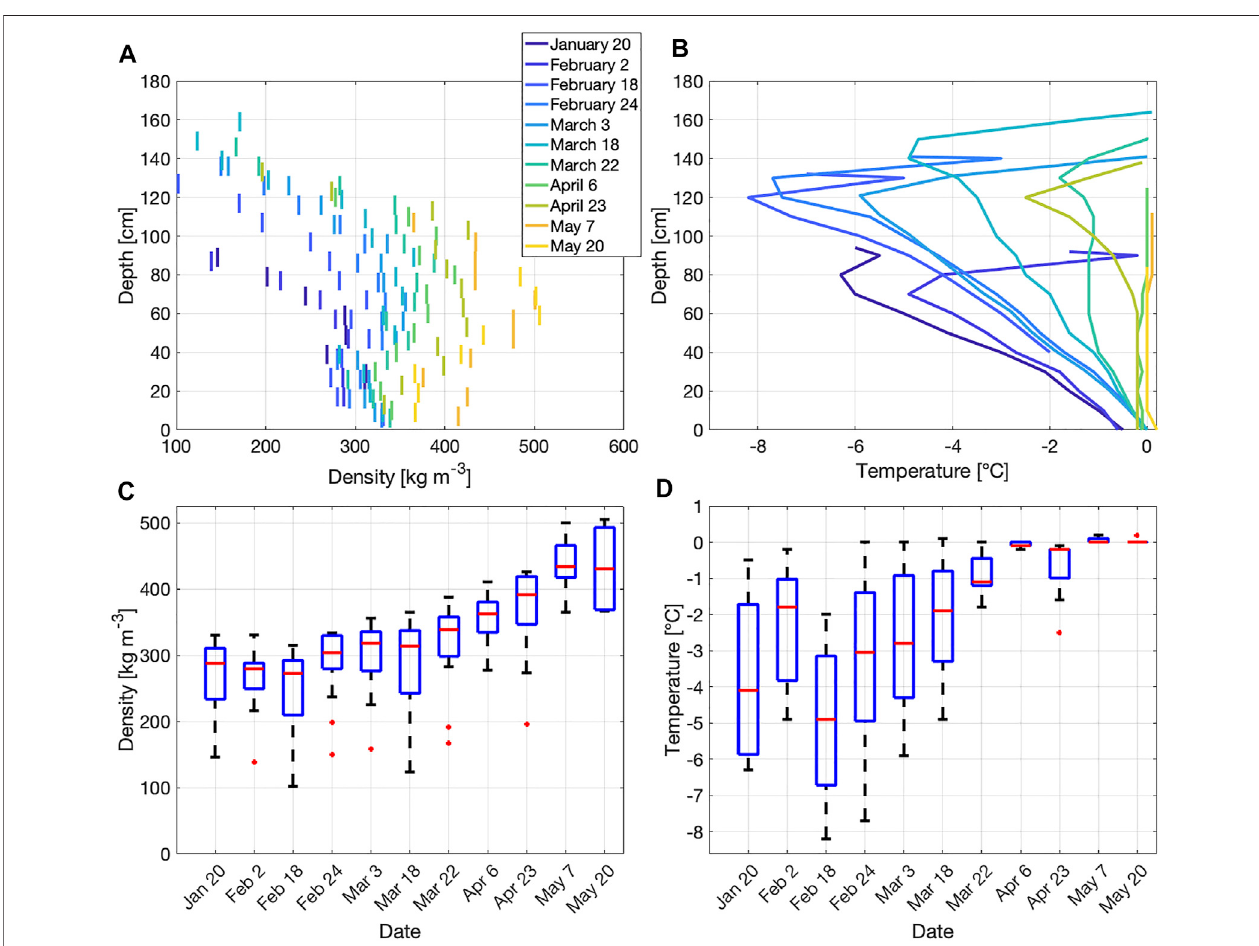
FIGURE 3 | (A) Pit-measured snow densities for each layer on each survey date. (B) Pit-measured snow temperatures for each survey date. (C) Boxplots of pit- measured snow densities on each survey date. (D) Boxplots of pit-measured snow temperatures on each survey date.